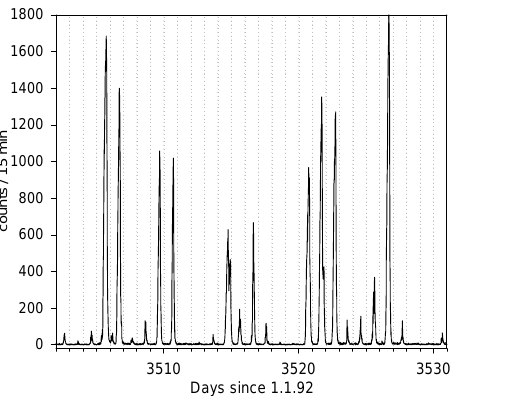
Figure 6: Times of very low background alternate with days with intense SDR signals. Fig. 6. Times of very low background alternate with days of intense SDR signals. SDR signals occur on some days (left). Multi days (MD) SDR signals occur in some days (Left). Multi days (MD) signals are formed by groups of signals are formed by groups of SDR signals occurring on consecutive days (right). SDR signals occurring on consecutive days (Right).